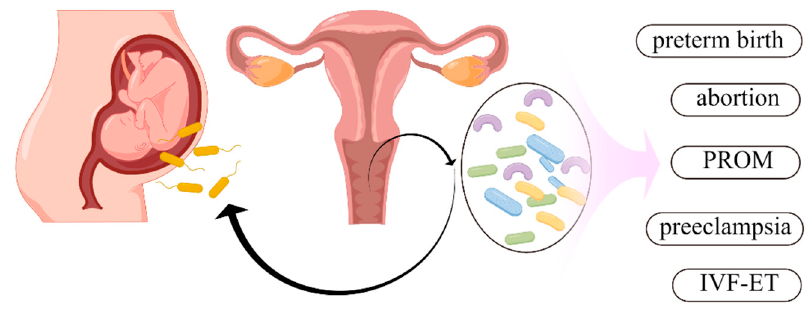
Figure 2. Vaginal microbiota and pregnancy outcomes. During pregnancy, vaginal microbiota is in- volved in intra-amniotic infection (IAI), spontaneous preterm birth, spontaneous abortion, premature rupture of membranes (PROM), preeclampsia, and in vitro fertilization and embryo transfer (IVF-ET).